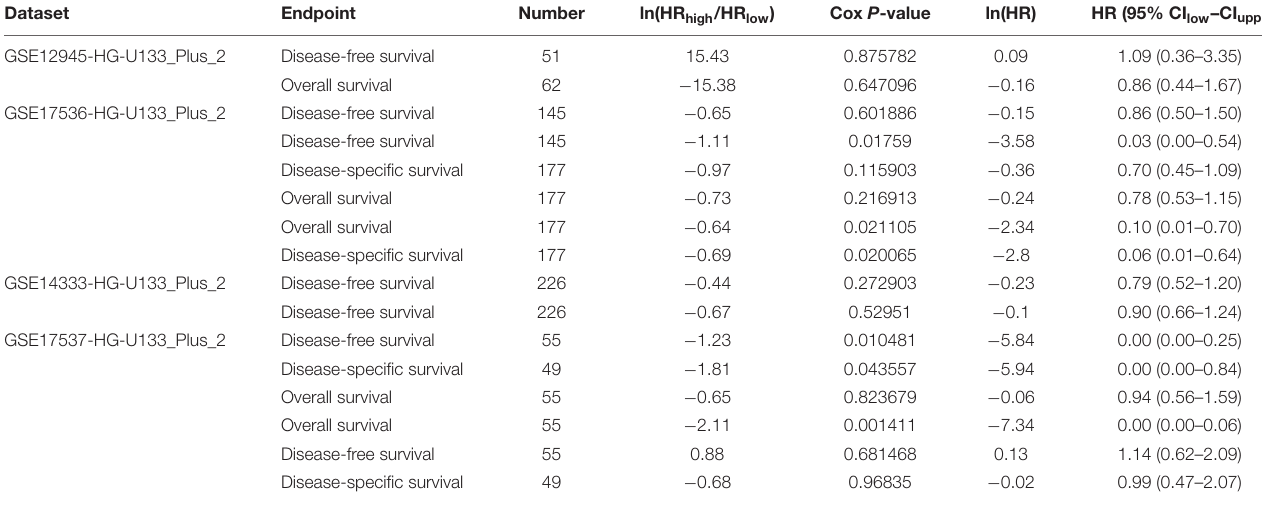
TABLE 6 | Survival analysis of MYC mRNA in colon and rectal cancer patients (the PrognoScan).